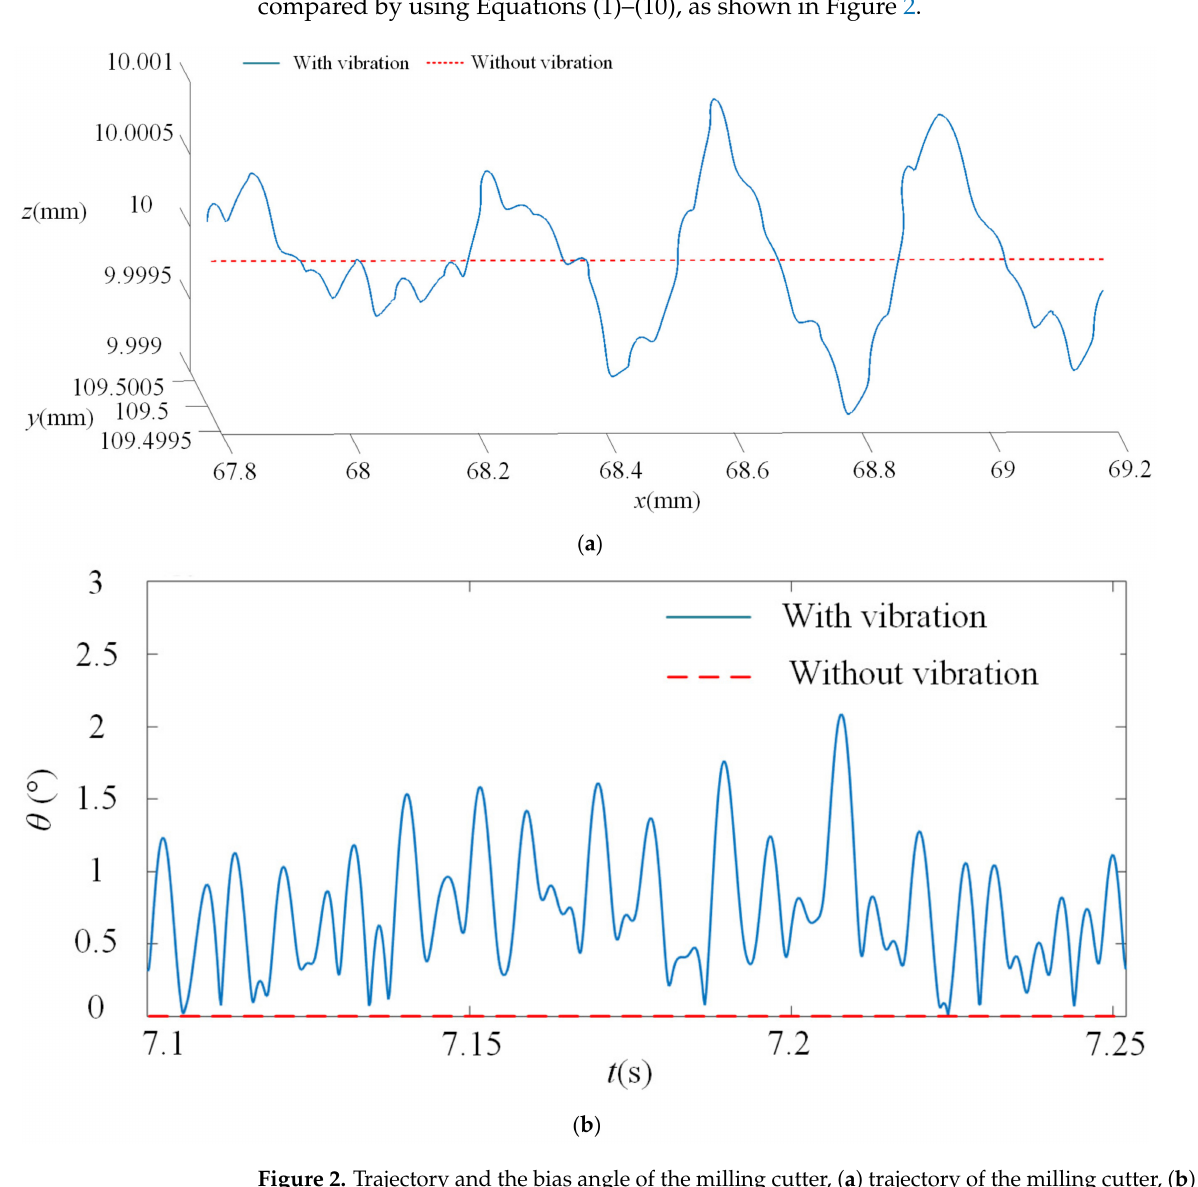
Figure 2. Trajectory and the bias angle of the milling cutter, ( a ) trajectory of the milling cutter, ( b ) bias angle of the milling